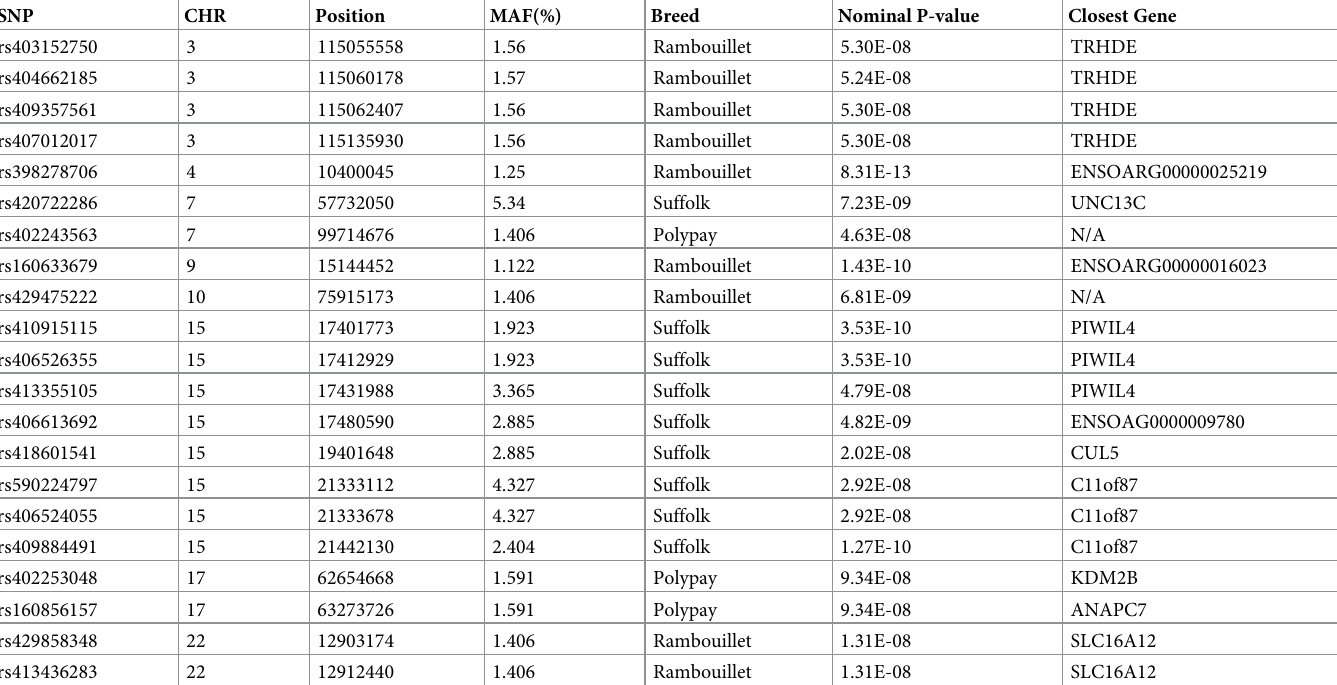
Table 3. Significant SNPs associated with untransformed M . ovipneumoniae mean DNA copy number in the individual breed